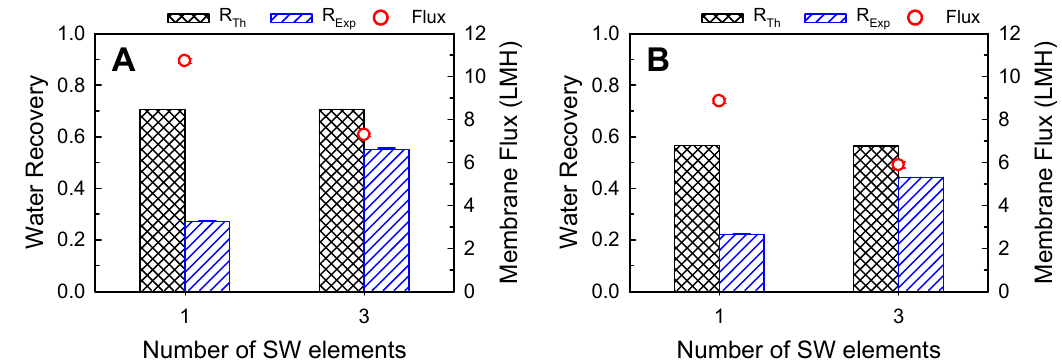
Figure 4 . Effect of membrane area on water recovery and membrane flux at feed and draw solution concentrations of ( A ) 10 and 58.4 g/L (1 M), ( B ) 70 and 233.8 g/L (4 M), respectively. The applied feed and draw flow rates were 10 LPM. An SW FO element has a membrane area of 15.3 m 2 . The error bars represent one standard deviation.